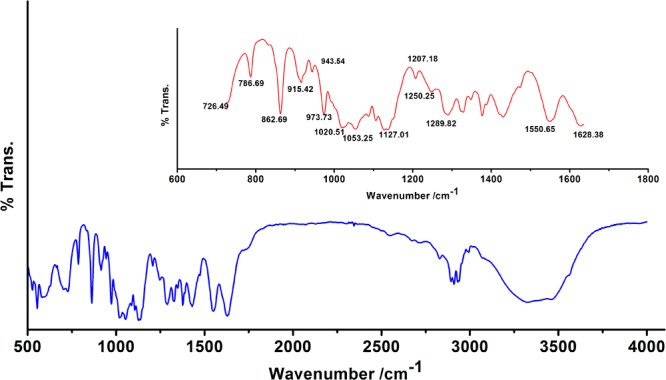
Fourier transform infrared (FTIR) absorption spectrum of the sugar fraction of Klebsiella biofilm matrix. Inset: Zoomed overview in the range 650–1,650 cm-1. Absorption peaks in mid and far-infrared regions (500–1,600 cm-1) reflected the absorption of sugars. The spectrum depicts the presence of β-glucans, mannans, sugar acids, and amines. Peaks at 1,207.18 and 1,250.25 cm-1 indicate the presence of 2′-acetylation indicating the presence of acetylated uronates. Apart from the sugar peaks, we also noted a broadband peak indicative of proteins (amide II) at 1,550.65 cm-1.